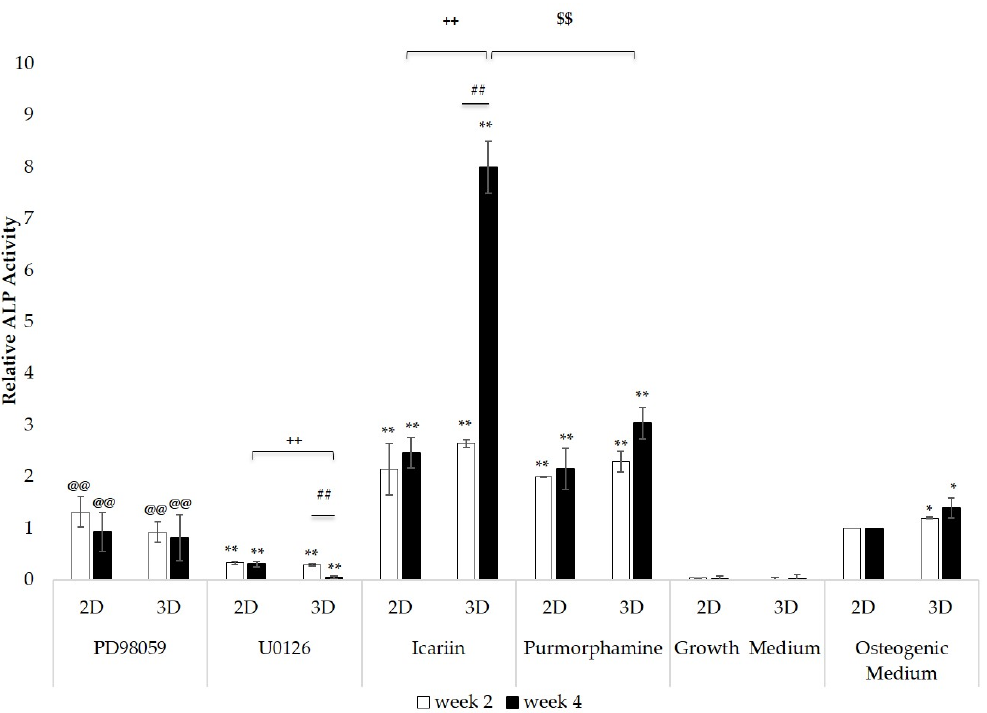
Figure 3. ALP activity was measured in bioprinted constructs (3D) and in monolayer cultures (2D) after two weeks and four weeks in culture. The graph shows fold changes in ALP activity relative to the osteogenic medium control grown in 2D culture conditions. Indicated error bars represent the standard deviation, and significance was determined by one-way ANOVA with Tukey′s multiple comparison test. * p < 0.05 compared to the osteogenic medium control in 2D culture conditions, ** p < 0.01 compared to the osteogenic medium control in 2D culture conditions, ## p < 0.01 between 3D bioprinted constructs at Week 2 and Week 4, ++ p < 0.01 between 3D bioprinted constructs and 2D monolayer cultures at Week 4, $$ p < 0.01 between Icariin and Purmorphamine treated 3D bioprinted